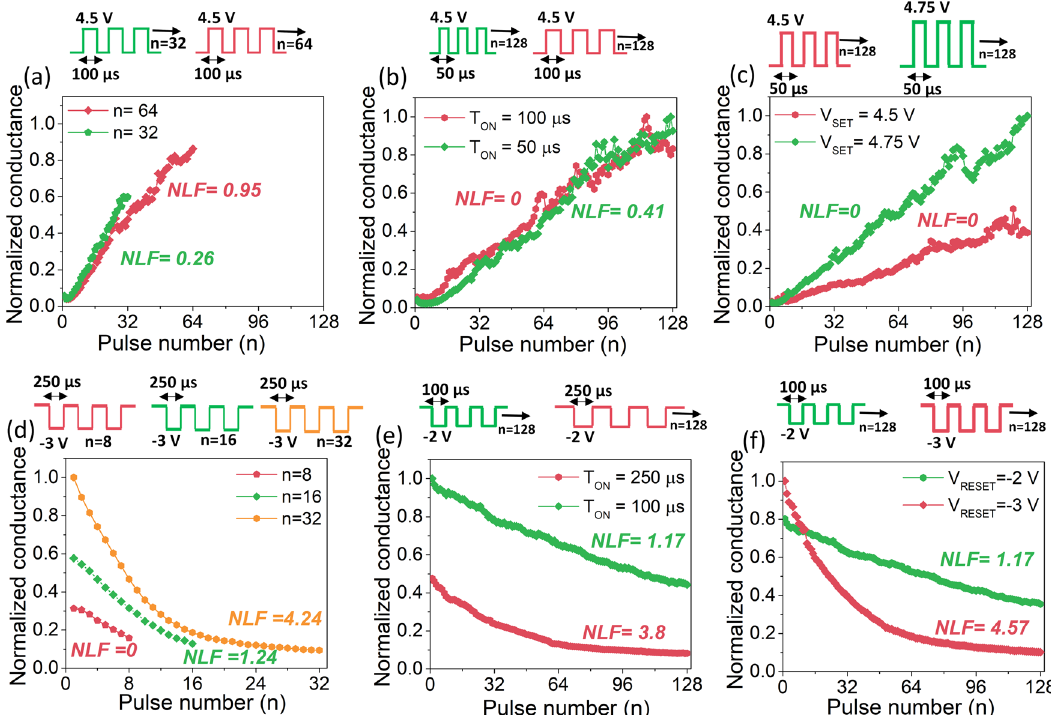
Fig. 4 Synaptic weight update. a Pulse number scaling in the potentiation regime of graphene / MoS 2 /SiO x synapse where the high linearity is maintained for n = 32, 64. b Pulse width scaling of the graphene / MoS 2 /SiO x synapse. Here, we observe that the linearity is maintained for higher pulse width of 100 µs. c Pulse amplitude scaling of the graphene / MoS 2 /SiO x device where the linearity is maintained for different pulse amplitudes viz., 4.5 V and 4.75 V. d Pulse number scaling observed in graphene / MoS 2 /SiO x device in depression regime where NLF = 0 is obtained for n = 8. e Pulse width scaling observed in graphene / MoS 2 /SiO x device for depression regime where linearity is observed with relatively lower pulse width of 100 µs. f Pulse amplitude scaling observed in graphene / MoS 2 /SiO x device for depression regime where linearity is observed with relatively lower pulse amplitude of − 2